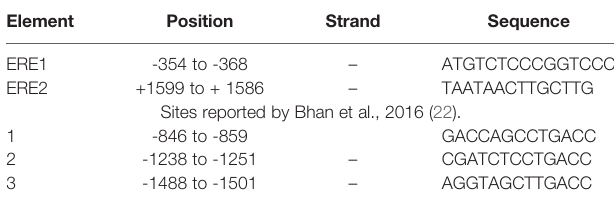
TABLE 1 | Sequences of EREs in EZH2